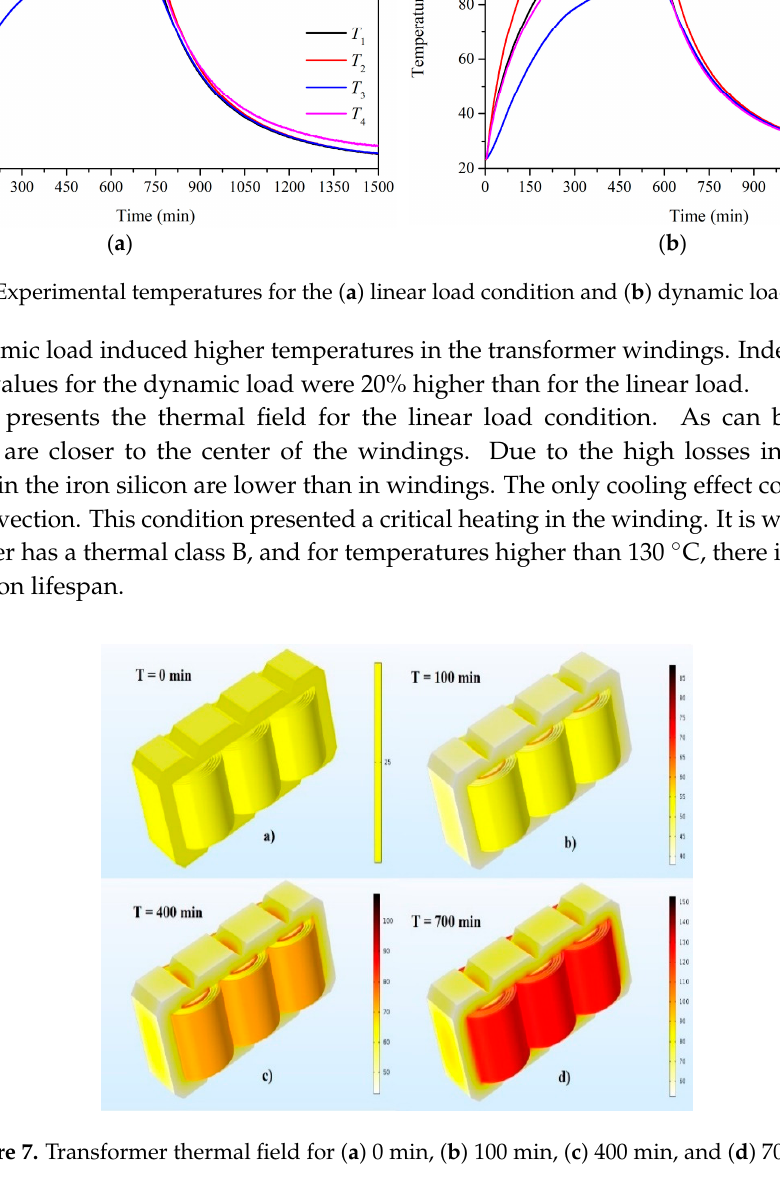
Figure 7. Transformer thermal field for ( a ) 0 min, ( b ) 100 min, ( c ) 400 min, and ( d ) 700 min.